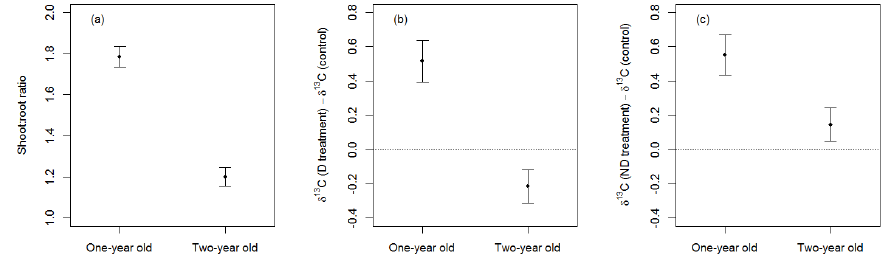
Figure 2. ( a ) Shoot:root ratios (mean ± 1SE) of one ‐ year ‐ old and two ‐ year ‐ old Fagus sylvatica plants